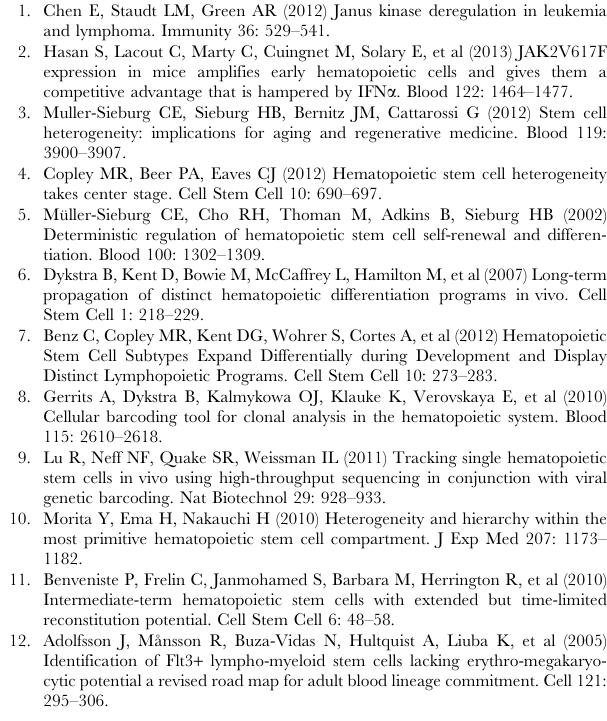
Figure 8. Two methods for resolving multipotent progenitor cells may identify alternate differentiation options for HSC. Trumpp and colleagues described a progression marked by acquisition of CD48 (MPP2 and 3) [45] and we show it as the top pathway. This option and particularly MPP that lack CD86, is promoted by the JAK2 mutant transgene. Alternatively, the Morrison lab showed that HSC can lose CD150 (formation of MPP 1, 2, 3 in the lower pathway) [46]. This route is diminished in the transgenics and most of the loss is in CD86